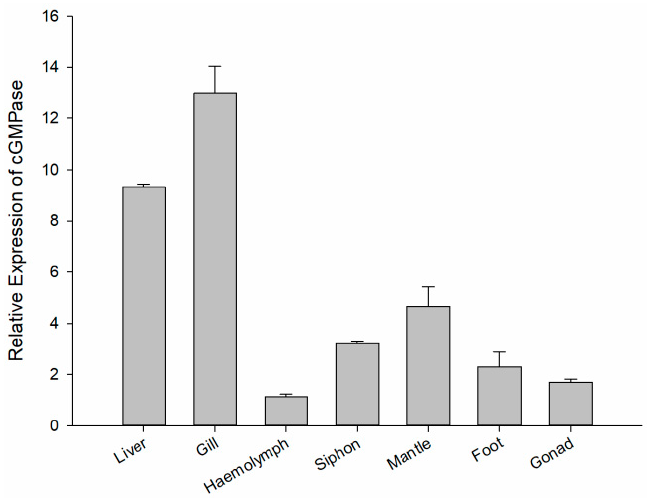
Figure 3. Expression analysis showing cGMPase expression profiles in different tissue, including liver, gill, haemolymph, siphon, mantle, foot, and gonad.